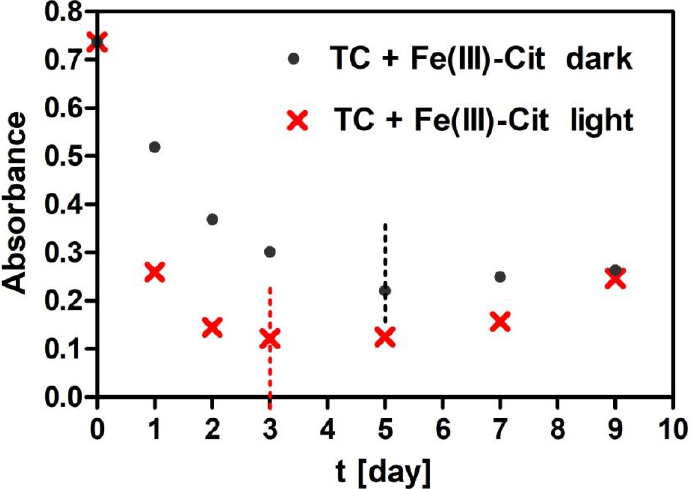
Figure 3. Changes in absorbance of TC + Fe(III)-Cit solutions stored at 30 °C as a function of time measured at the maximum long wavelength absorption band of TC. Dashed lines indicate intervals until which the samples were not turbid.